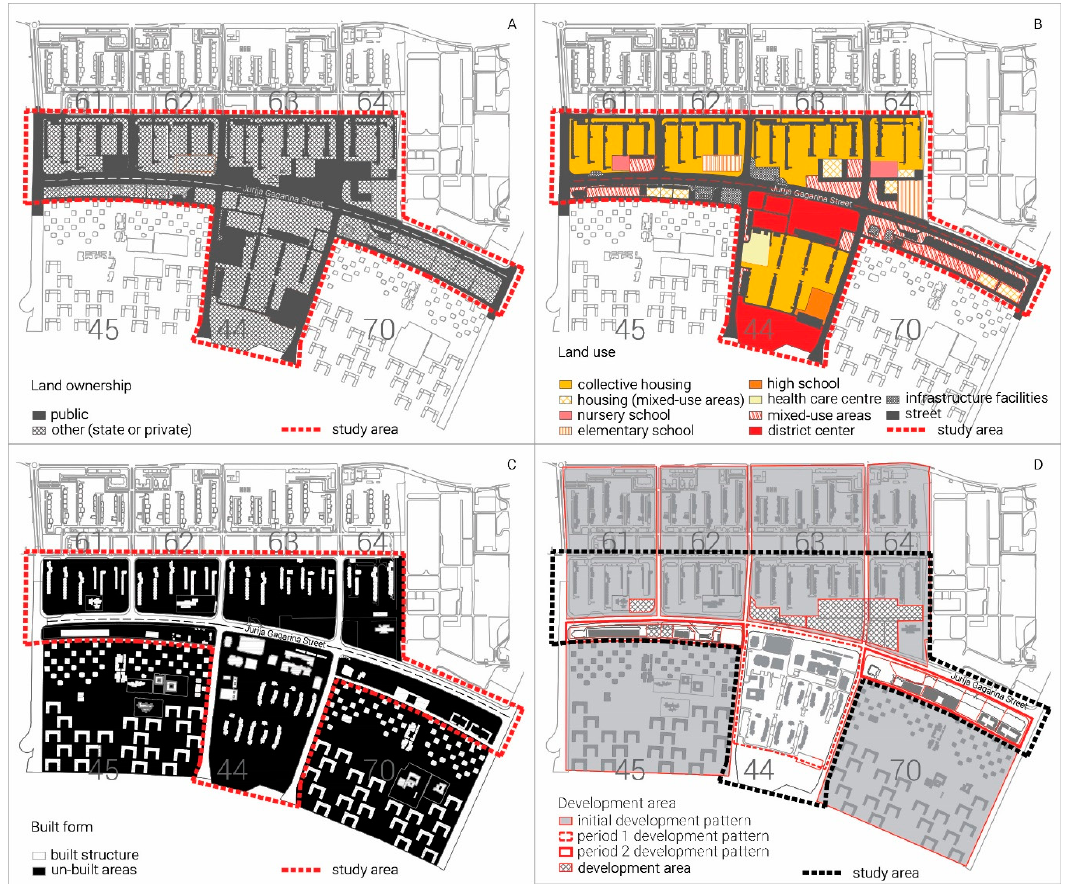
Figure 5. Morphogenesis of Jurija Gagarina Street, period 2: ( A ) Land ownership, ( B ) land-use, ( C ) built form, and ( D ) pattern of growth (source: authors).